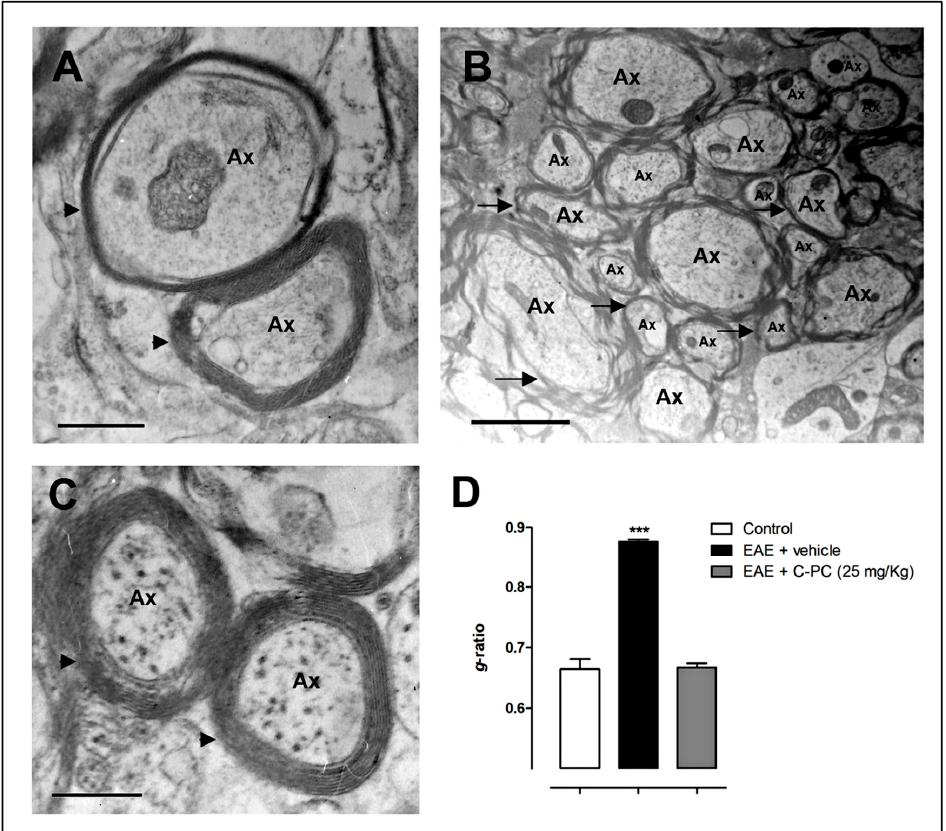
Figure 1. C-PC-induced remyelination in an EAE model in Lewis rats. Panels show representative electron microscopy images of brain biopsies from ( A ) non-diseased; ( B ) EAE-vehicle treated and ( C ) EAE-C-PC 25 mg/Kg treated animals; ( D ) g -ratio = [axon diameter/(myelin + axon) diameter] (mean ± S.E.M. *** p < 0.001 vs. control group, ANOVA + Newman-Keuls tests by using GraphPad Prism Software). C-PC at 25 mg/Kg or the vehicle were administered i.p. once a day from day 0 until day 12 after immunization ( n = 10 each group). Control (non-immunized) animals received saline instead of encephalitogen. Brain samples were taken at the end of the study period (day 24 post-immunization). Arrowheads or arrows indicate normal myelin structure/thickness or myelin damage/loss, respectively. Ax: axon. Bar = 200 nm.